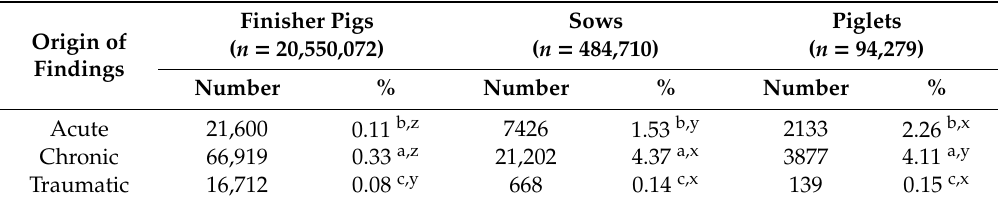
Table 5. Comparison of the number of individual patho-anatomic findings in limbs in finisher pigs, sows and piglets slaughtered in the slaughterhouses.